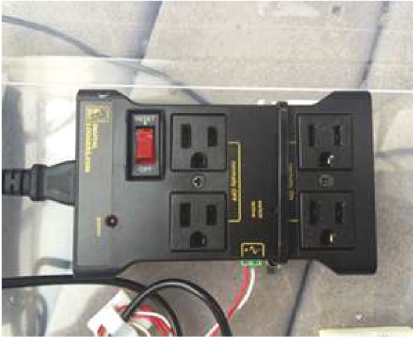
Figure 6: Raspberry Pi controls.